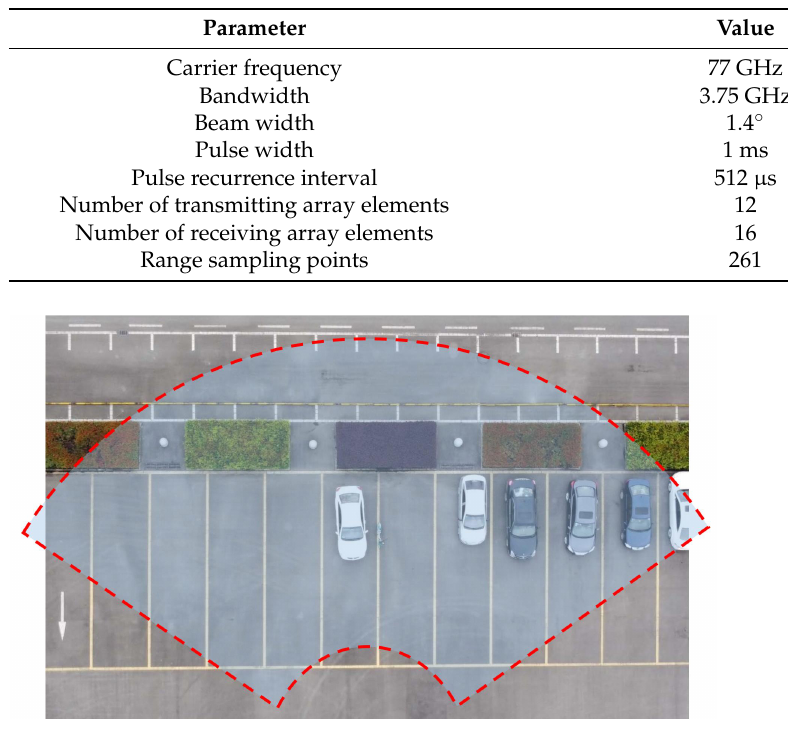
Table 3. Parameters of the Measured Data.